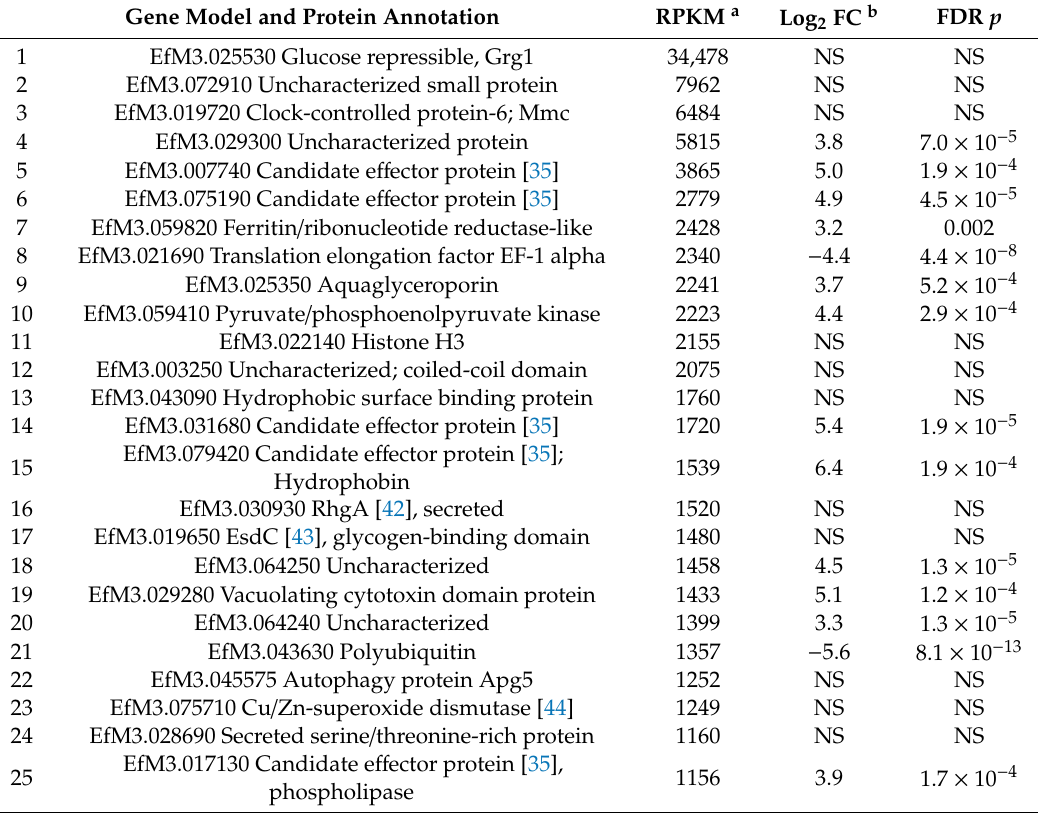
Table 4. The 25 most abundant Epichloë festucae transcripts in strong creeping red fescue choke stroma